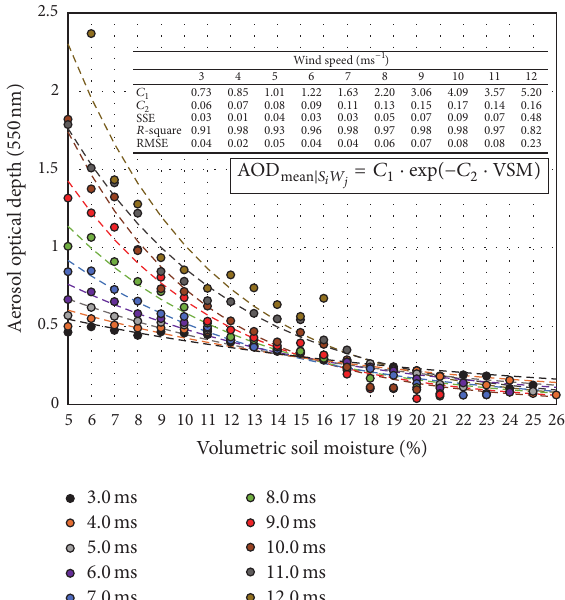
Figure 3: The relationship between average AOD and volumetric soil moisture under different wind speed conditions. The uppermost curves on the graph represent the strongest wind speed conditions. Constants ( 𝐶 1 and 𝐶 2 ) and statistical information for each curve are included